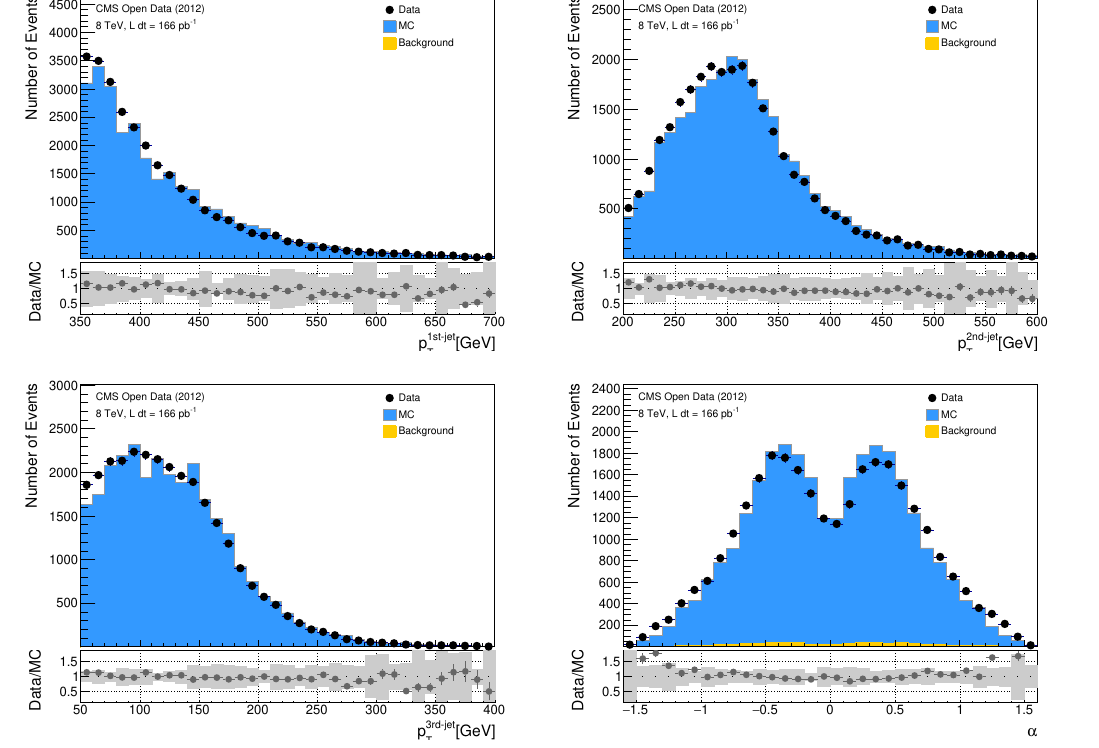
Figure 4 . Comparison of the p T distributions for the leading (upper left), sub-leading (upper right) and sub-sub-leading jets (lower left) for data and MC, as well as the inclusive (cid:11) distribution (lower right) for data and MC. The grey band indicates the corresponding systematic